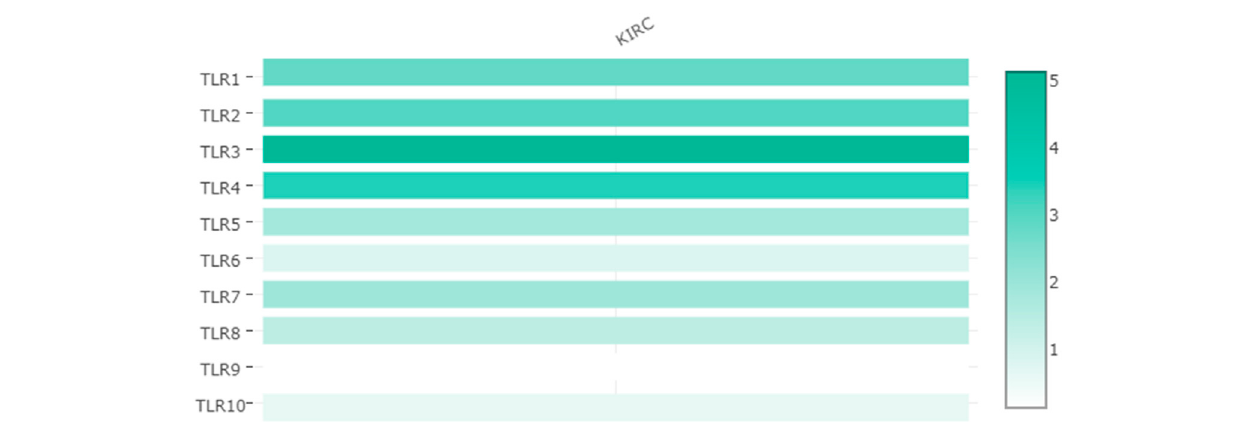
FIGURE 3 | Relative expression levels of TLRs in